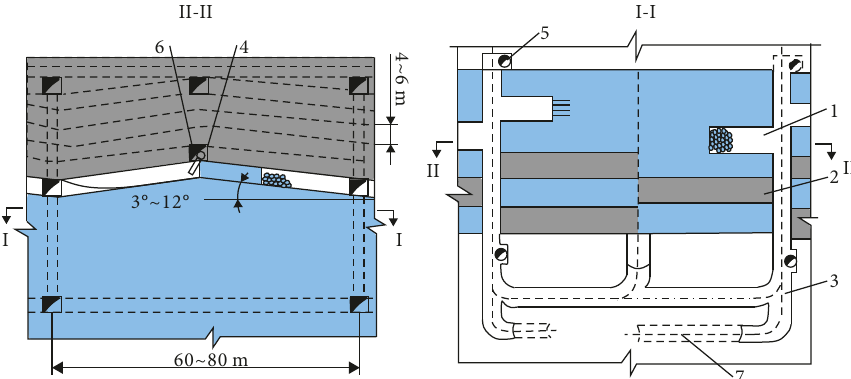
Figure 3: Schematic diagram of the stope of downward cemented filling method. (1-mining drift; 2-filling drift; 3-sublevel haulage road; 4- sublevel filling road; 5-orepass; 6-filling material transportation pipeline; 7-ramp; ore (blue); cemented backfill body